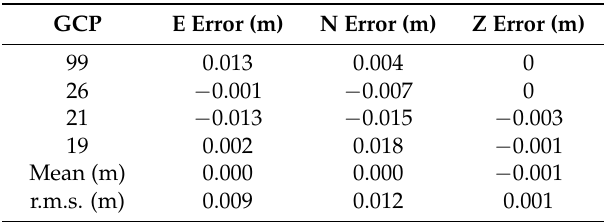
Table 4. Pix4D georeferencing